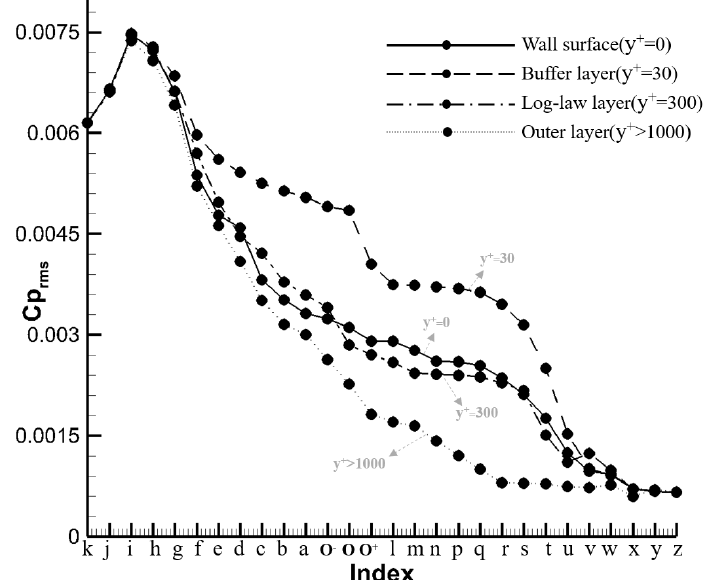
Figure 8. The distribution of Cp rms in different layers within boundary layer near expansion